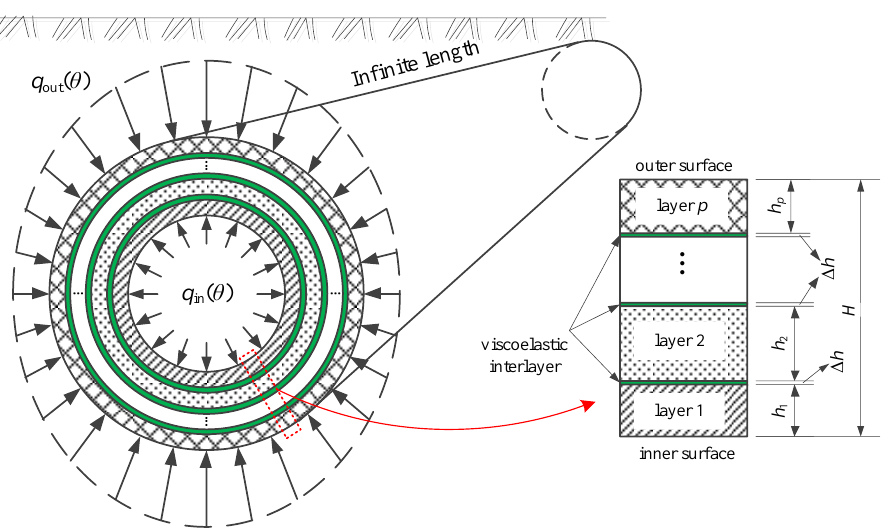
Figure 1. Schematic for the viscoelastic composite pipe under sustained compression as studied here.